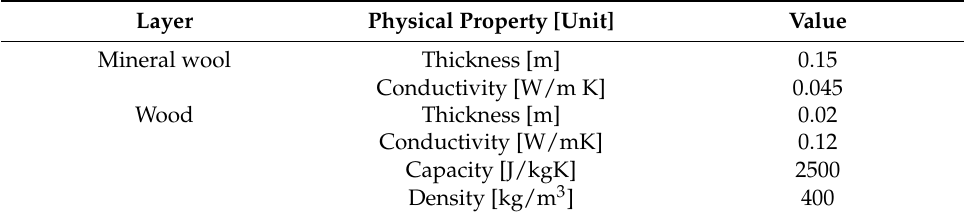
Table 1. Material properties of roof structure consisting of 2 layers.